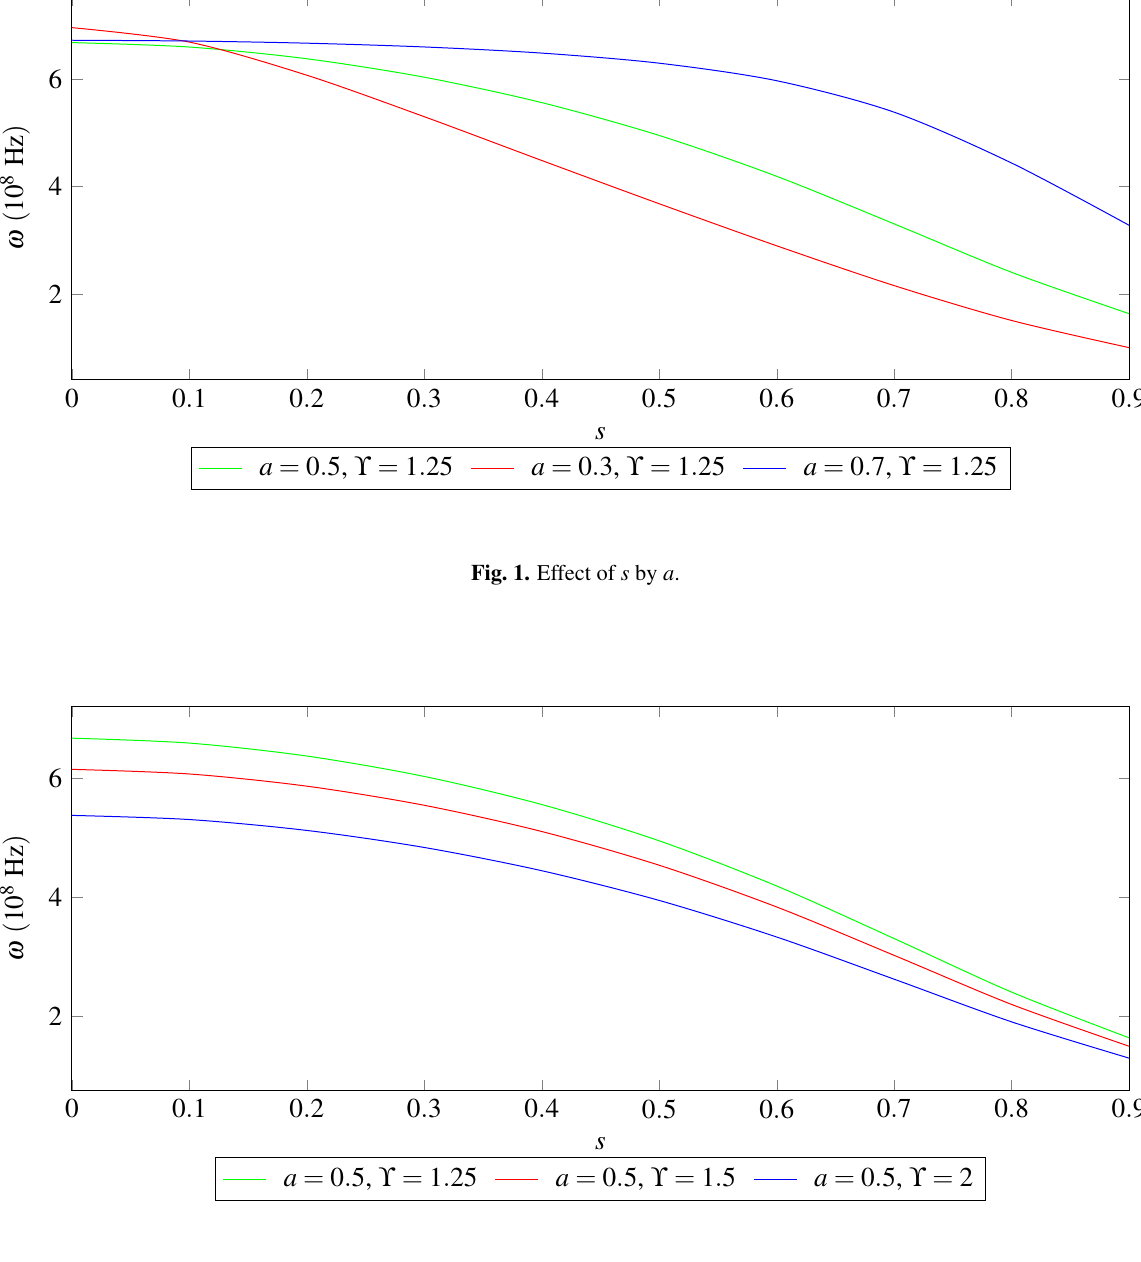
Fig. 2. Effect of s by ϒ